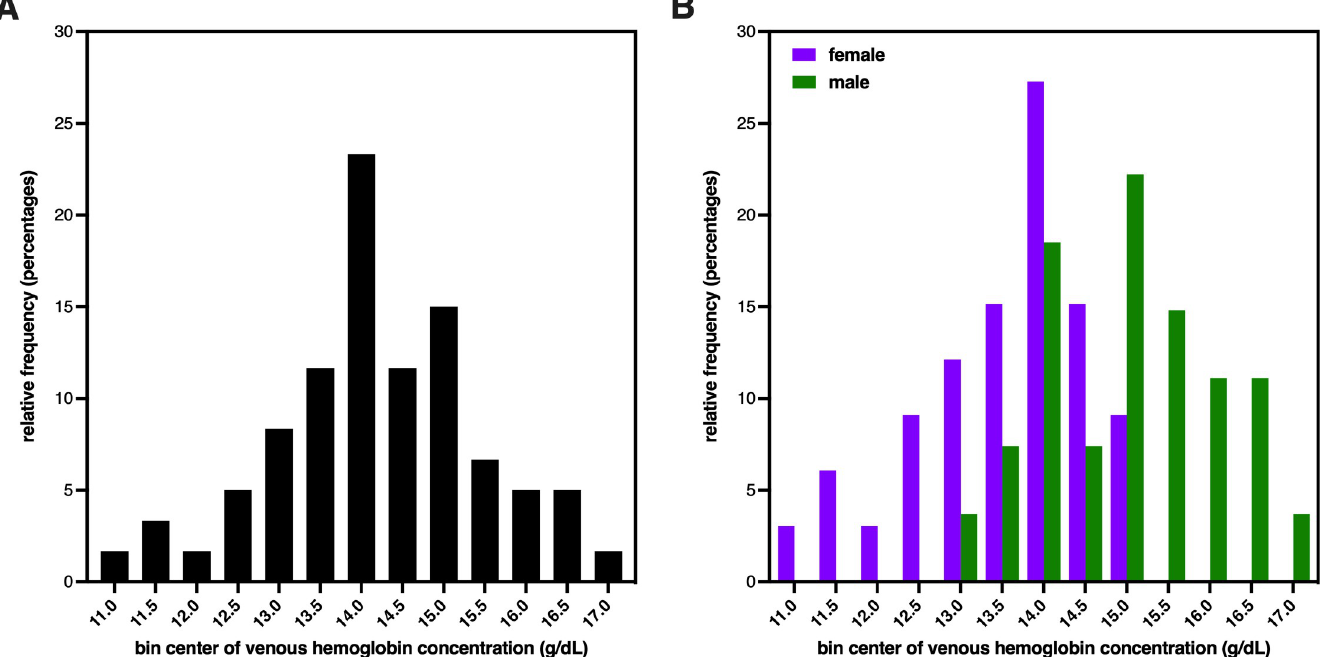
Fig 1. Distribution of hemoglobin concentration in study population. (A): Histogram of group Hb values determined from venous blood using ADVIA-2120. The mean Hb for all participants (n = 60) was 14.22 ± 1.28 g/dL. (B): Histogram of Hb values from females (purple) and males (green) determined from venous blood using ADVIA-2120. The mean Hb for female participants (13.54 ± 1.07 g/dL, n = 33) was significantly lower than male (15.05 ± 1.01 g/dL, n = 27), p < 0.0001.